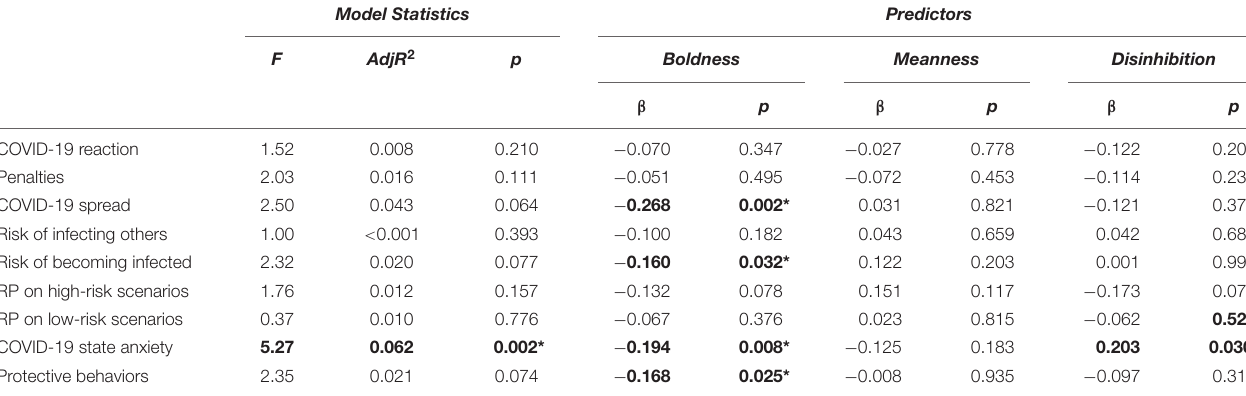
TABLE 2 | Regression models with psychopathic traits as predictors of risk perceptions and protective behaviors. Model